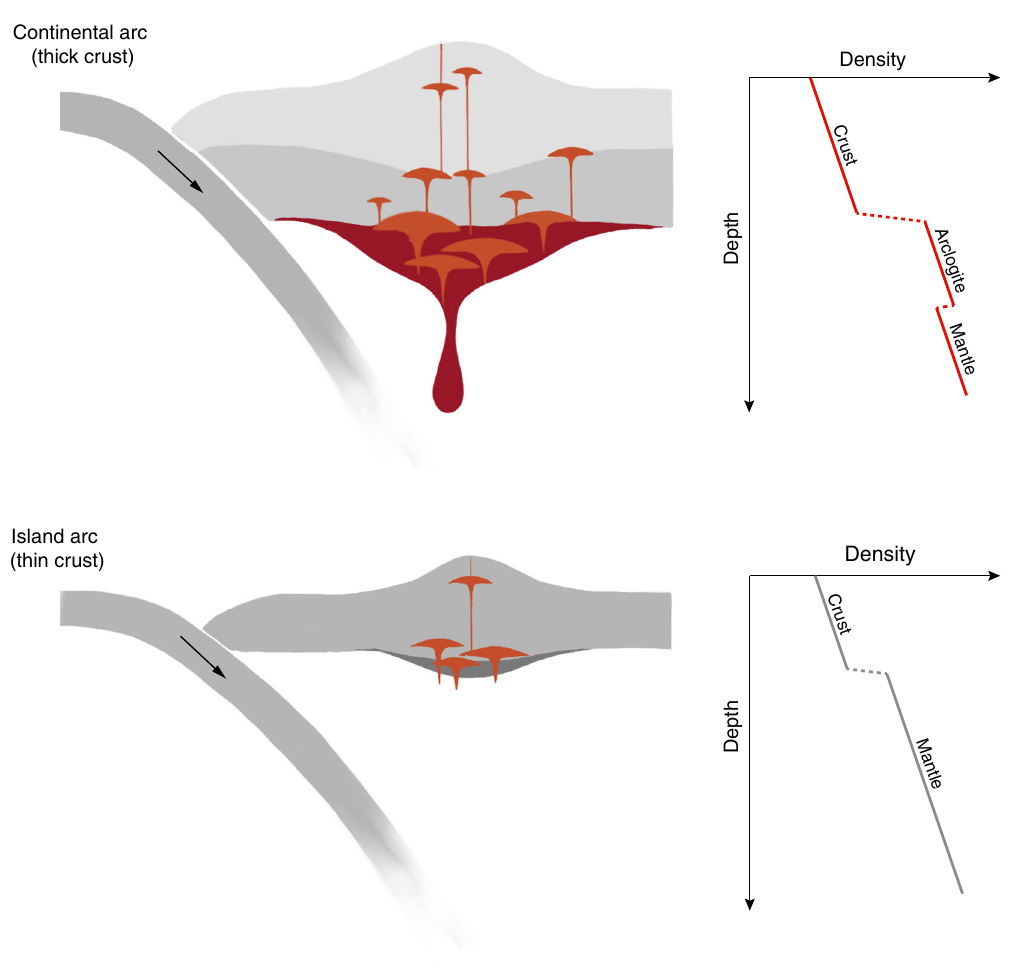
Fig. 5 Cartoon showing magma differentiation in continental arcs vs. island arcs and schematic crustal density pro fi les. The dense arclogites beneath continental arcs contain garnet and rutile, hence the dark red color. Co-precipitation of garnet, rutile, and sul fi des at the roots of continental arcs removes Fe 13,15,63 , Nb (relative to Ta), and chalcophile elements 64 from the magmas and drives calc-alkaline differentiation. In the thickened continental arc